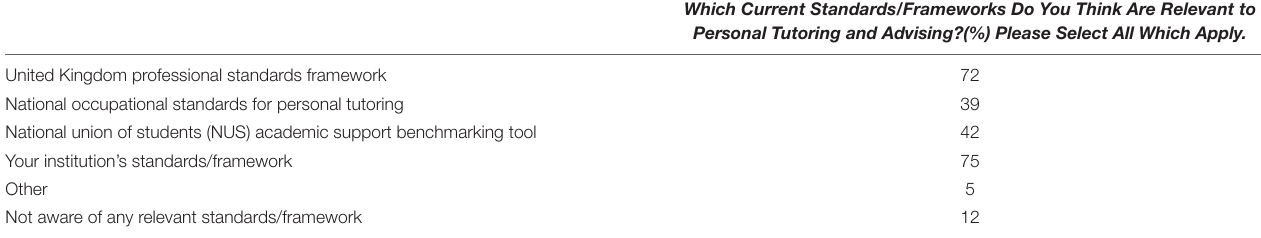
TABLE 4 | Responses regarding the relevance of pre-existing standards to personal tutoring and